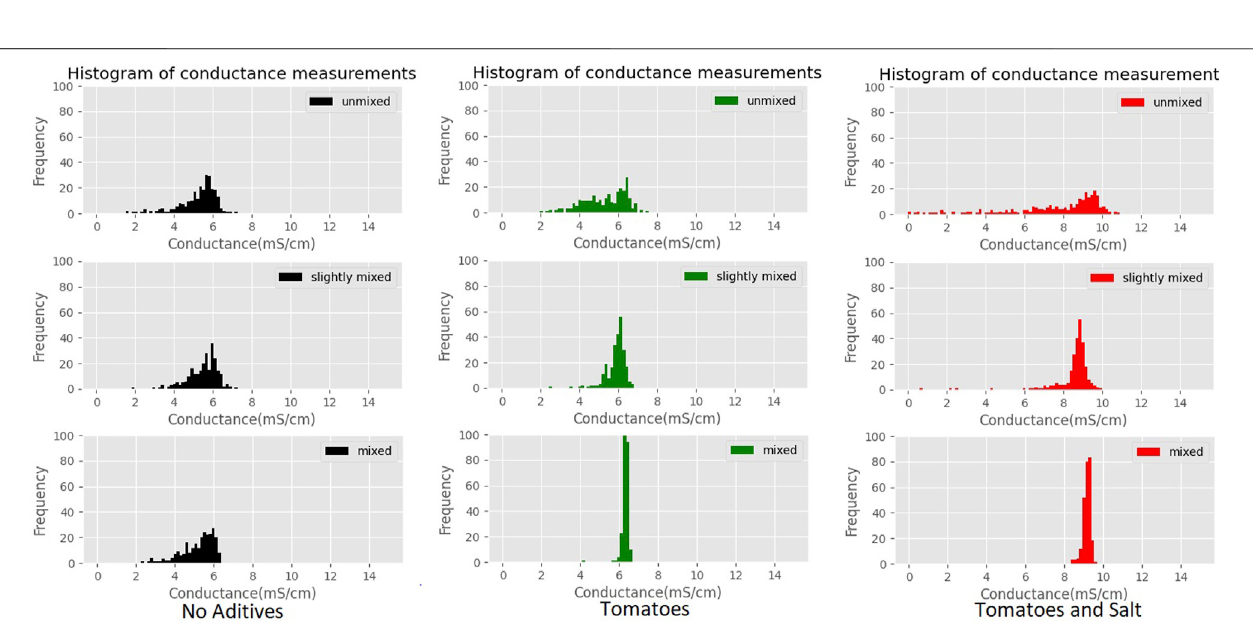
FIGURE 9 | Histograms of conductance measurements at each of the mixing stages and with different mixtures of additives.